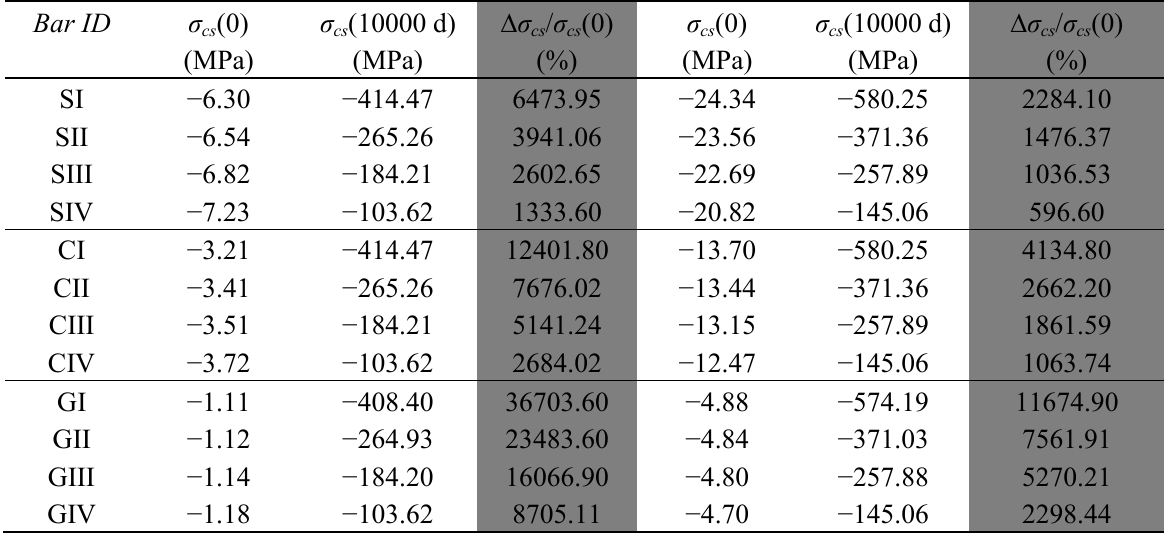
Table 5. Instantaneous stresses in the reinforcement